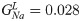
Long-term changes in concentrations of various ionic species in the model interneuron from APdE9 mice (GNaL=0.028 mS/cm2) in response to external stimulus during simulations shown in Fig 4a.(a) [Na+]i, (b) [Cl−]i, (c) [K+]o, (d) [Na+]o, (e) [Cl+]0, and (f) [K+]i. Inset shows enhanced view of changes in ionic concentrations at the time of applied stimulus.